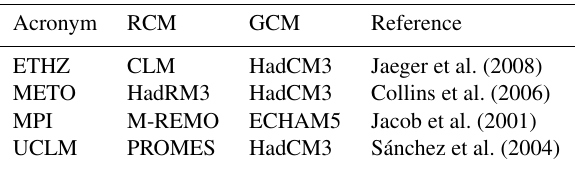
Table 2. Name and acronym of the regional climate models used in this study. Adapted from Herrera et al. (2010) and von Gunten et al.